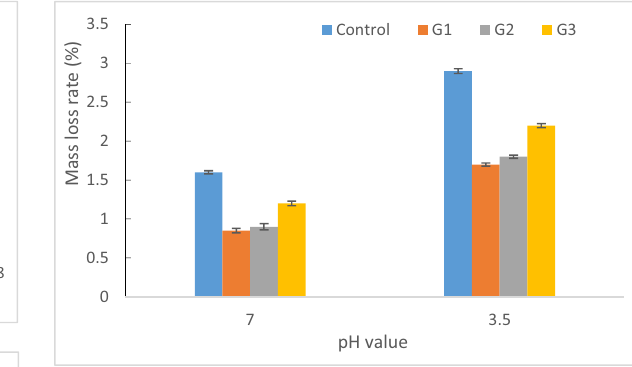
Figure 5: Relationship of mass loss rate with pH value and di ff erent particle size groups of nano TiO 2 under spraying of pure water and acid rain solution for